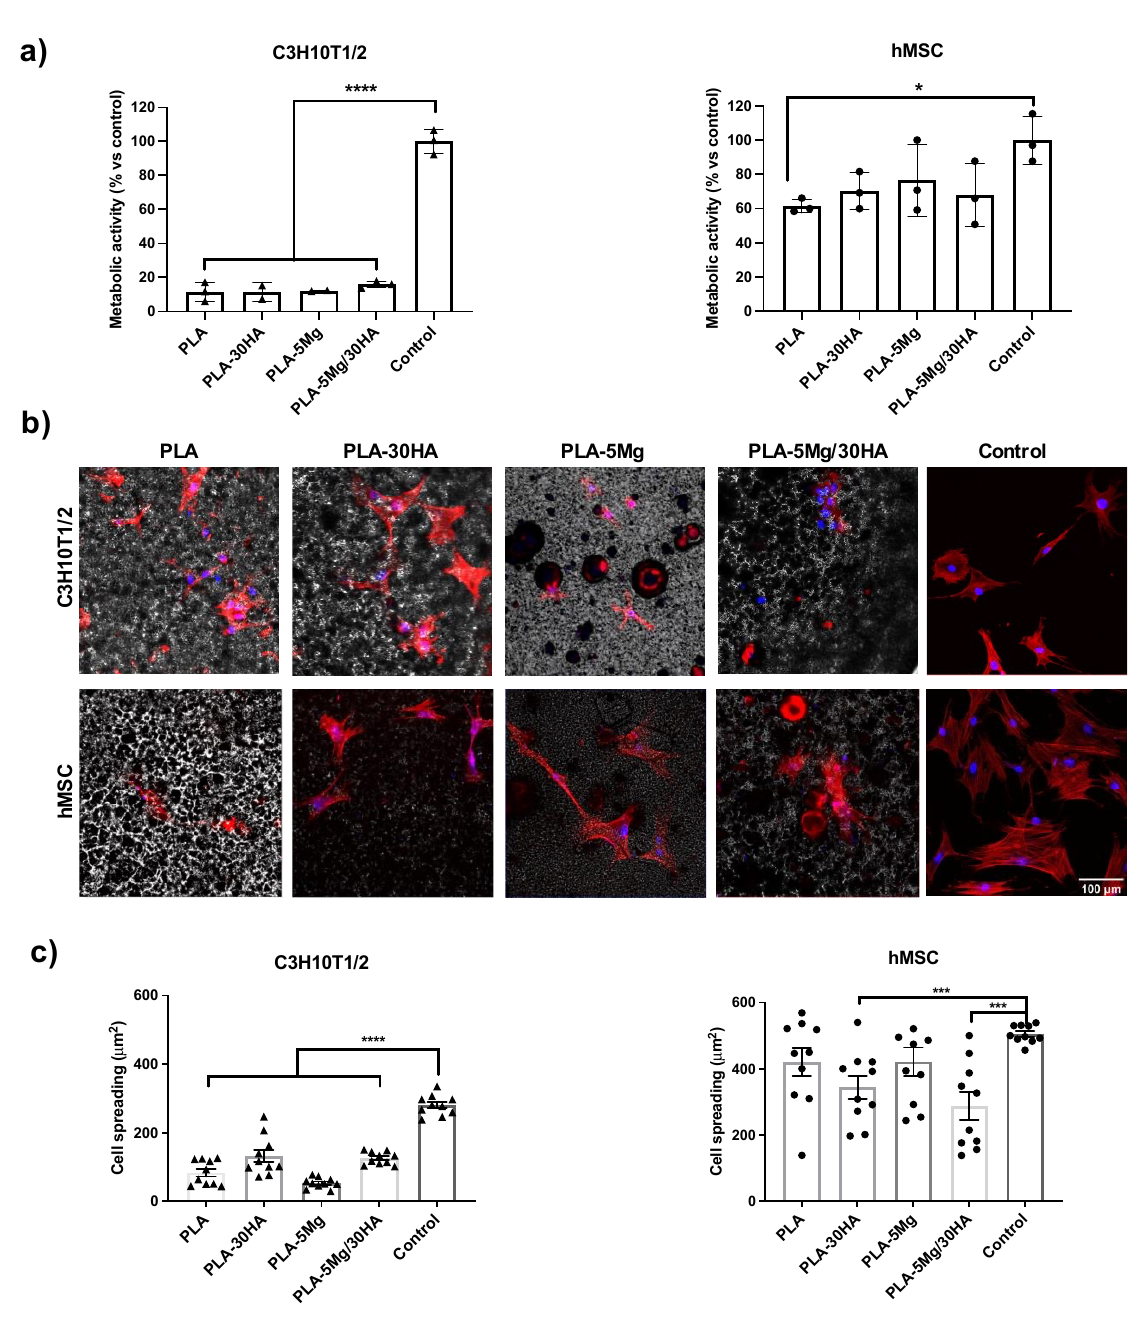
Figure 6. Cell adhesion 24 h after cell-seeding . ( a ) Metabolic activity measured with Alamar blue assay ( n = 3 replica per surface). ( b ) Confocal images of cells on the different surfaces after staining for Actin cytoskeleton (Red) and DAPI nuclear staining (Blue) (scale 100 µm). ( c ) Quantification of cell shape and spreading on different surfaces ( n = 10 cell per condition).